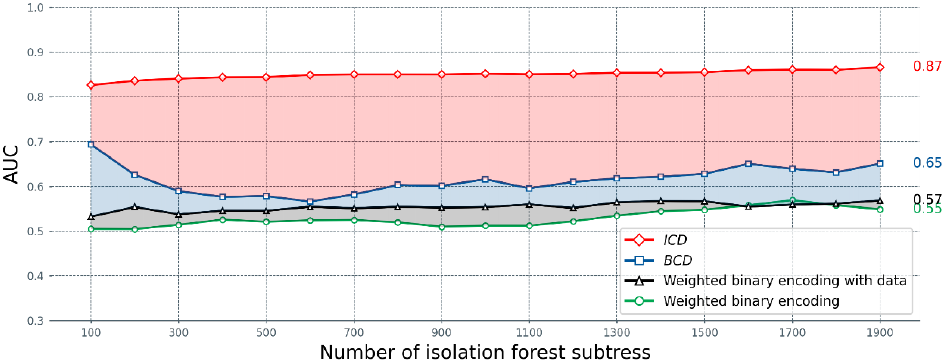
Figure 8. Effect of different numbers of subtrees on detection results.